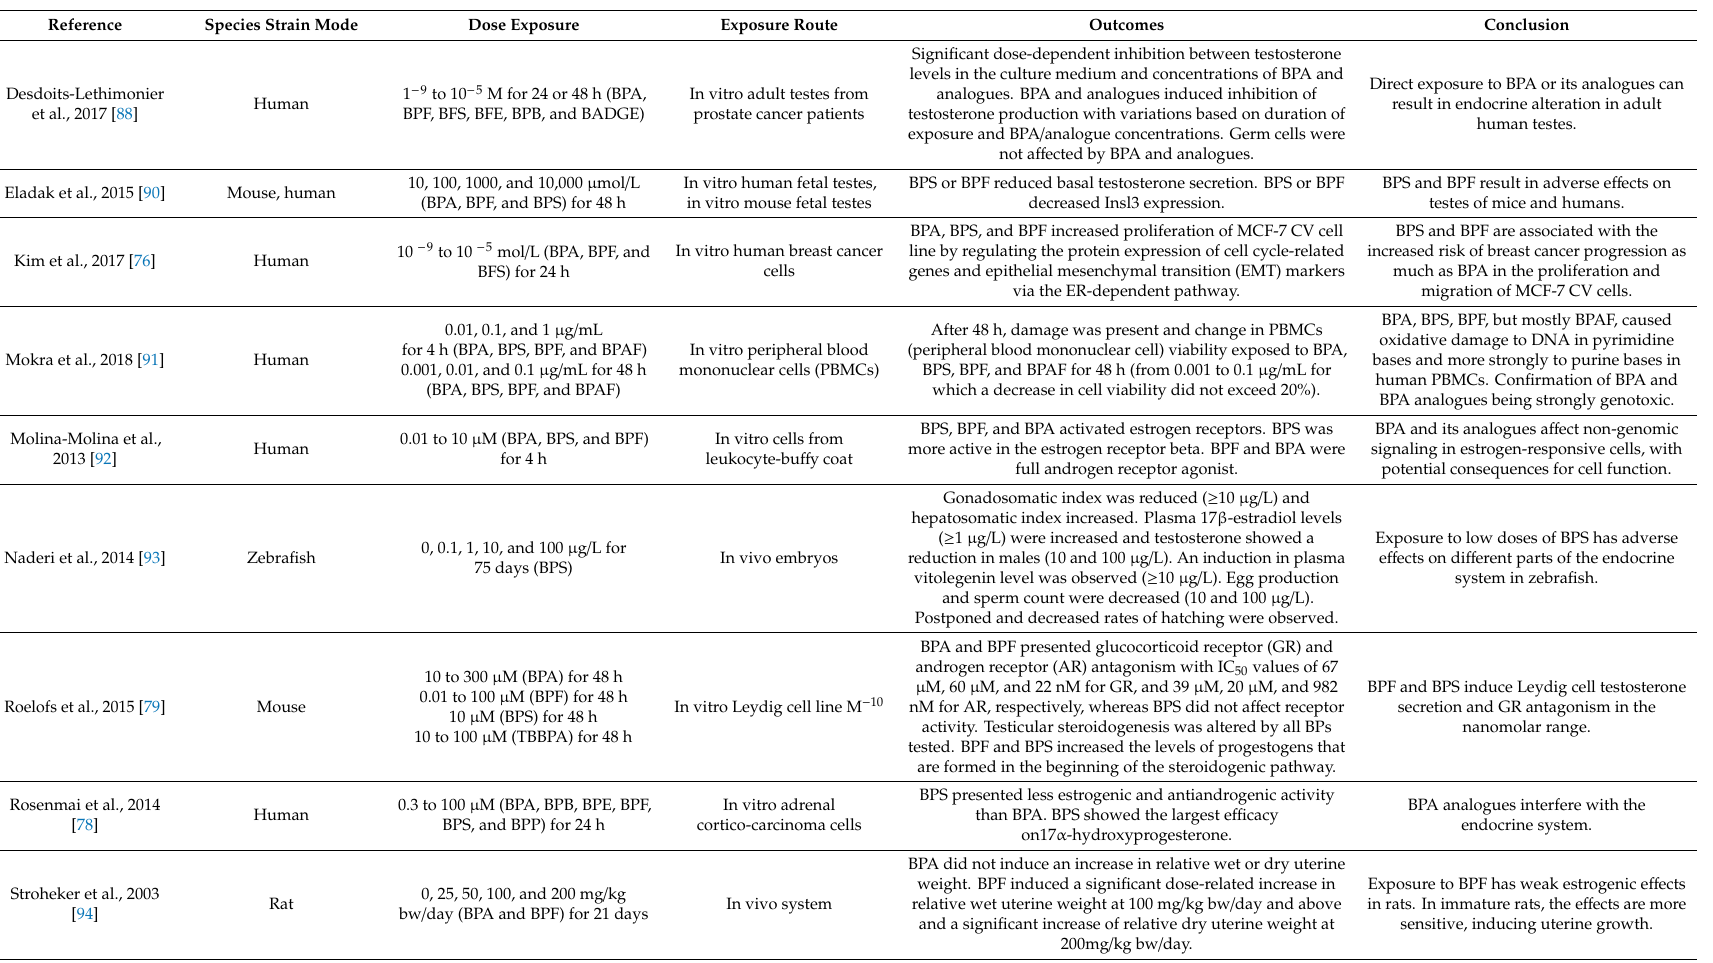
Table 2. Studies about hormonal e ff ects of